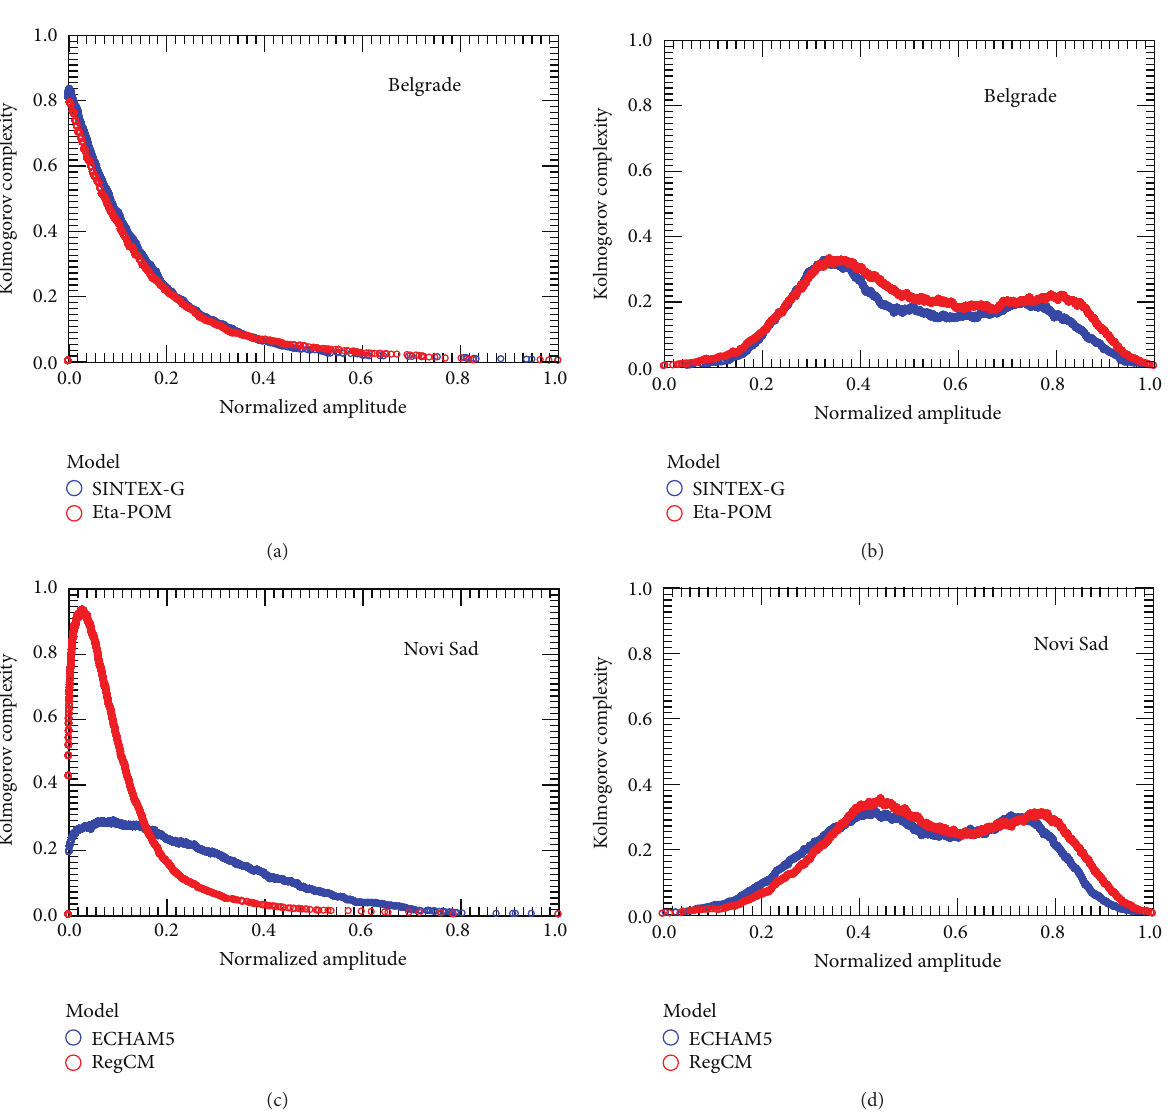
Figure 6: Kolmogorov complexity for the (a) precipitation and (b) air temperature time series for Belgrade and (c) precipitation and (d) temperature for Novi Sad, in Serbia, obtained from climate simulations using different models. On 𝑥 -axis are depicted the values of the time series normalized as 𝑥 𝑖 = (𝑋 𝑖 − 𝑋 min )/(𝑋 max − 𝑋 min ) , where {𝑋 𝑖 } is the time series of the precipitation or air temperature, 𝑋 max = max {𝑋 𝑖 } , and 𝑋 min = min {𝑋 𝑖 }